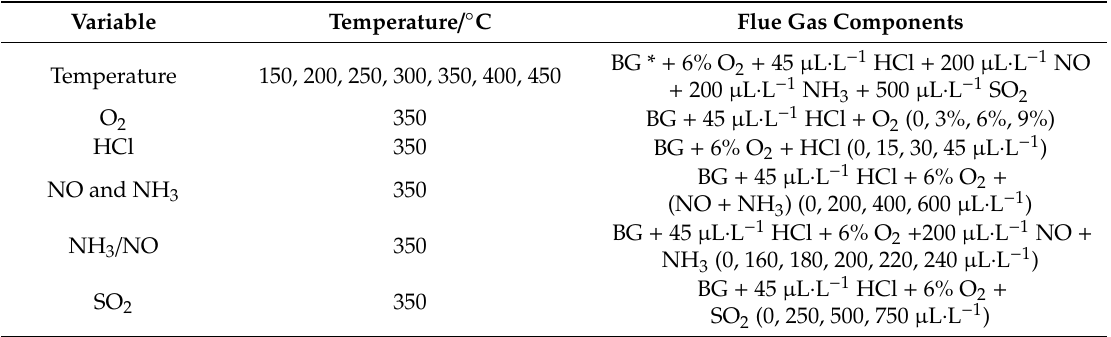
Table 2. Experimental